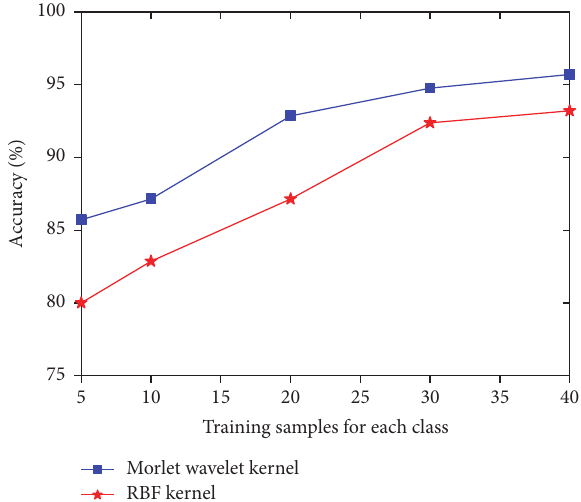
Figure 10: The diagnostic accuracy based on the Morlet wavelet kernel and RBF kernel LS-SVM optimized by PSO, respectively.